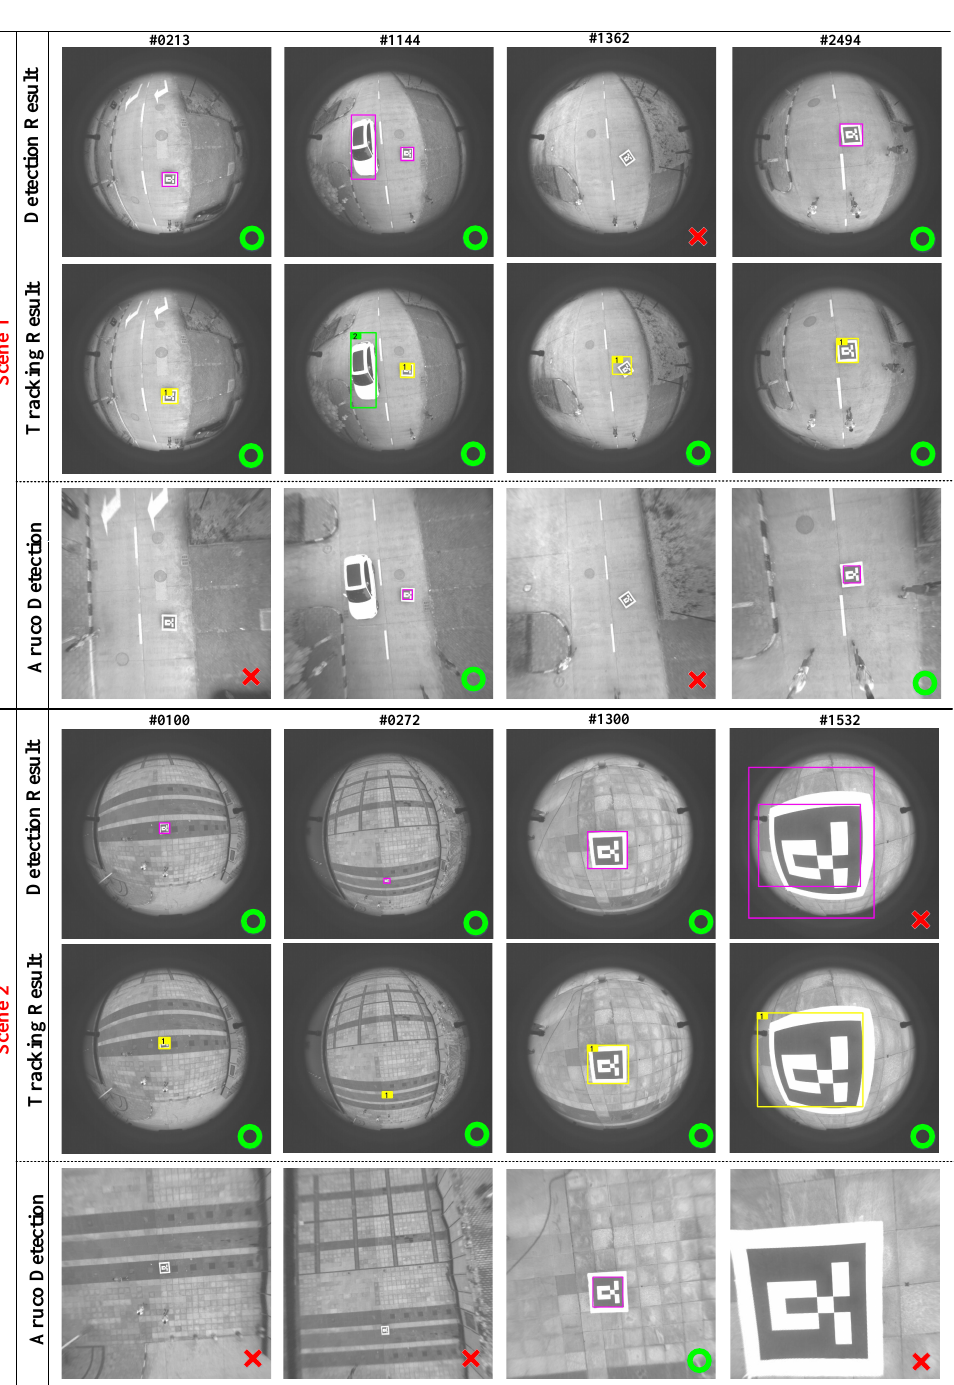
Figure 12. The infrared image target detection and tracking results in two scenarios compared with an ArUco marker: detection results. The green circle represents correct detection and the red x indicates wrong